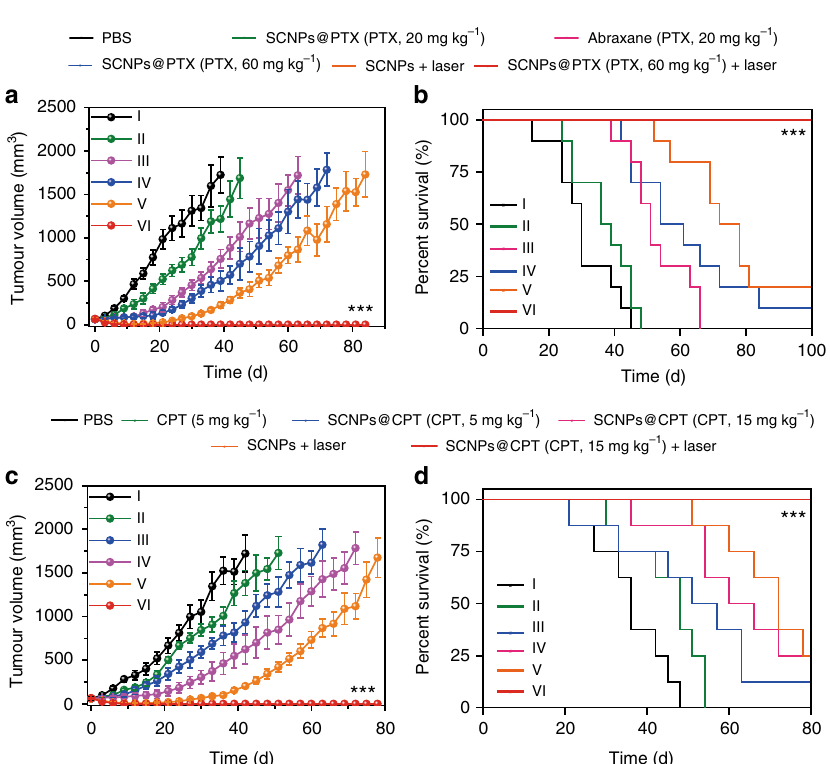
Fig. 7 In vivo thermo-chemotherapy on xenograft tumours. a Tumour volume changes and b Kaplan – Meier survival curves of the mice bearing HeLa xenografts treated with different formulations after one injection ( n = 10). c Tumour volume changes and d Kaplan – Meier survival curves of mice bearing A549 xenografts treated with different formulations after one injection ( n = 8). The laser density was 0.5 W cm − 2 , and the irradiation time was 5 min. Data are expressed as means ± s.e.m., *** P <